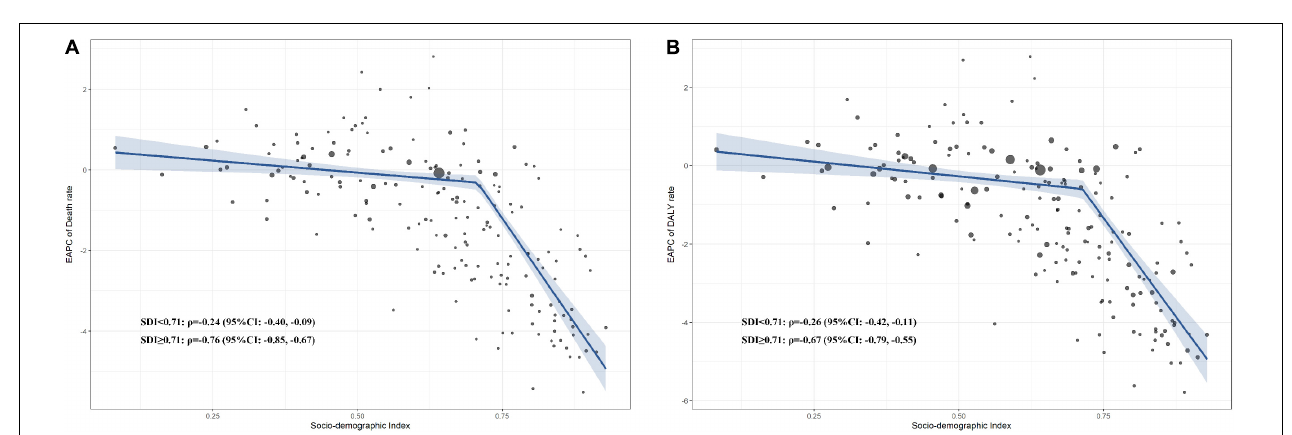
FIGURE 2 | Correlation between EAPC of high LDL-C attributable age-standardized death and DALY rate in 2019. (A) Correlation between EAPC of high LDL-C attributable death and SDI; (B) Correlation between EAPC of high LDL-C attributable DALY and SDI. DALY, disability-adjusted life year; SDI, social-demographic index; EAPC, estimated annual percentage change; LDL-C, low-density